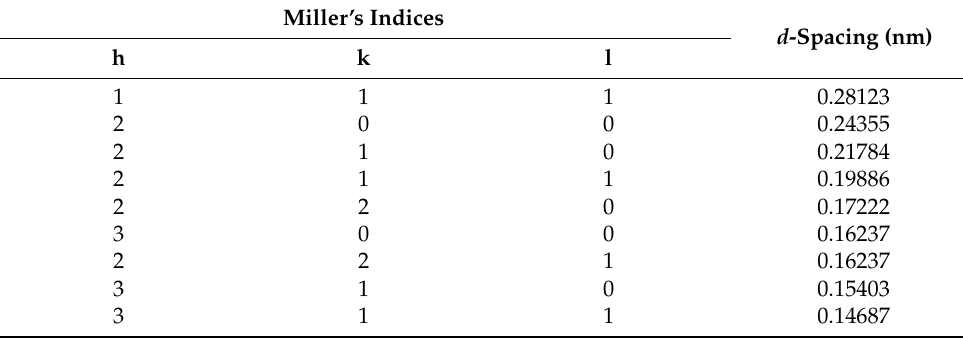
Table 4. Atomic plane distances of cubic ZnO